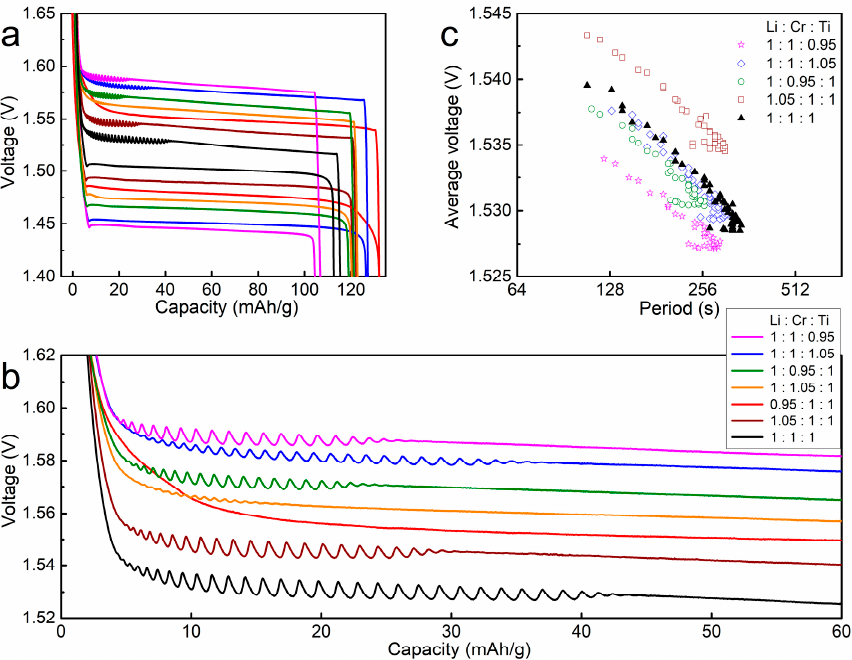
Figure 6. ( a ) The galvanostatic discharge/charge curves of LiCrTiO 4 sintered in a powder form at a temperature of 850 ◦ C with an elemental ratio of Li:Cr:Ti as 1:1:1 (black), 1.05:1:1 (wine), 0.95:1:1 (red), 1:1.05:1 (orange), 1:0.95:1 (olive), 1:1:1.05 (blue) and 1:1:0.95 (magenta), respectively. ( b ) The enlarged view in the end of charge plateaus. The data are shifted along the vertical axis (1:1:1 ±0 mV; 1.05:1:1 ±10 mV; 0.95:1:1 ±20 mV; 1:1.05:1 ±30 mV; 1:0.95:1 ±40 mV; 1:1:1.05 ±50 mV; 1:1:0.95 ±60 mV) for viewing convenience. ( c ) The relationship between the period and the average voltage, which were calculated from ( b ).